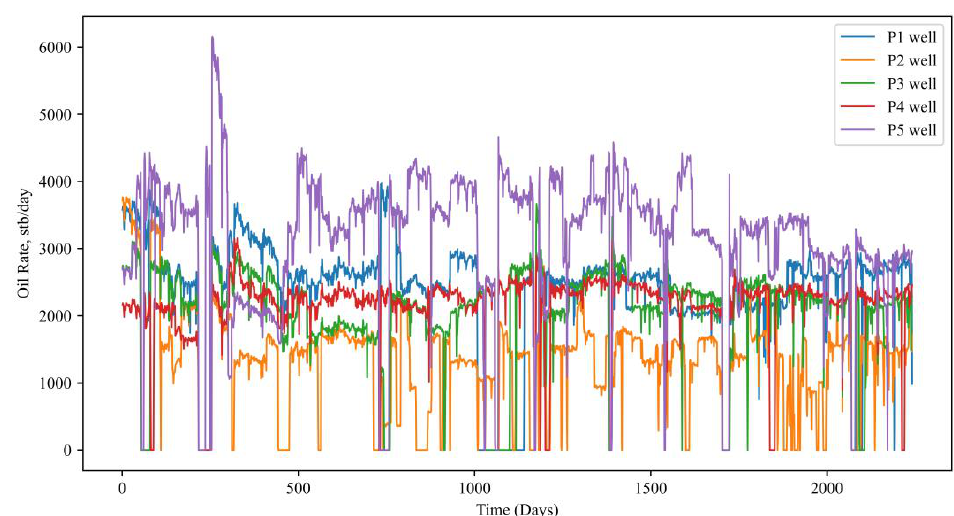
Figure 6. The raw daily oil production series of five wells in a well pattern.